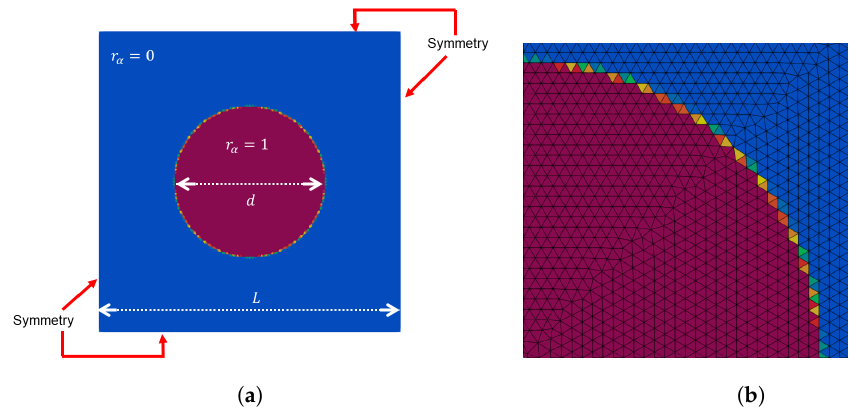
Figure 1. Computational domain, BCs, ICs ( a ) and the detail of the mesh at the interface for the 2D static drop ( b ). Red colour corresponds to r α = 1 whereas the blue one to r α =